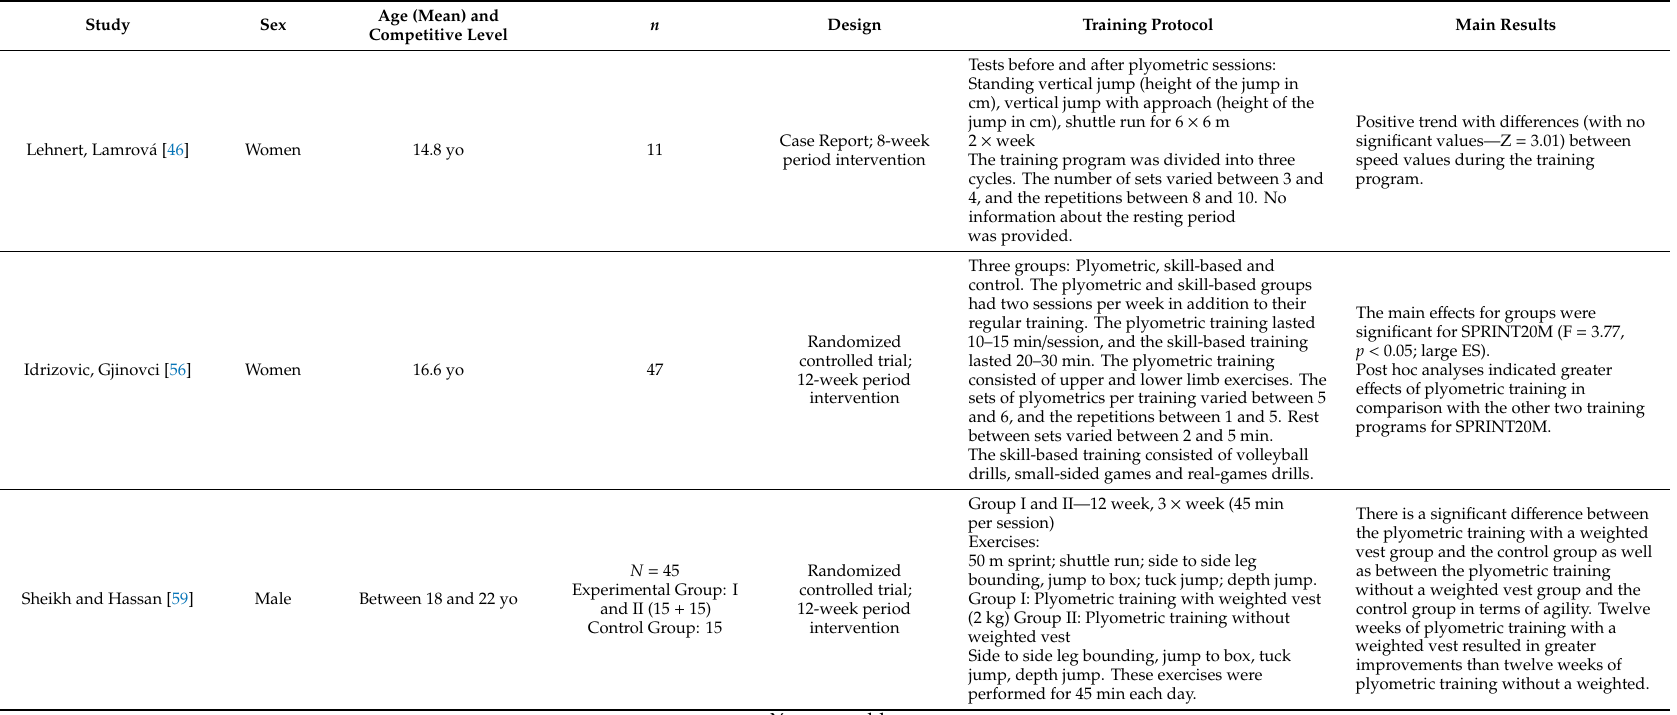
Table 6. Studies that investigated the e ff ects of plyometric training programs on agility /